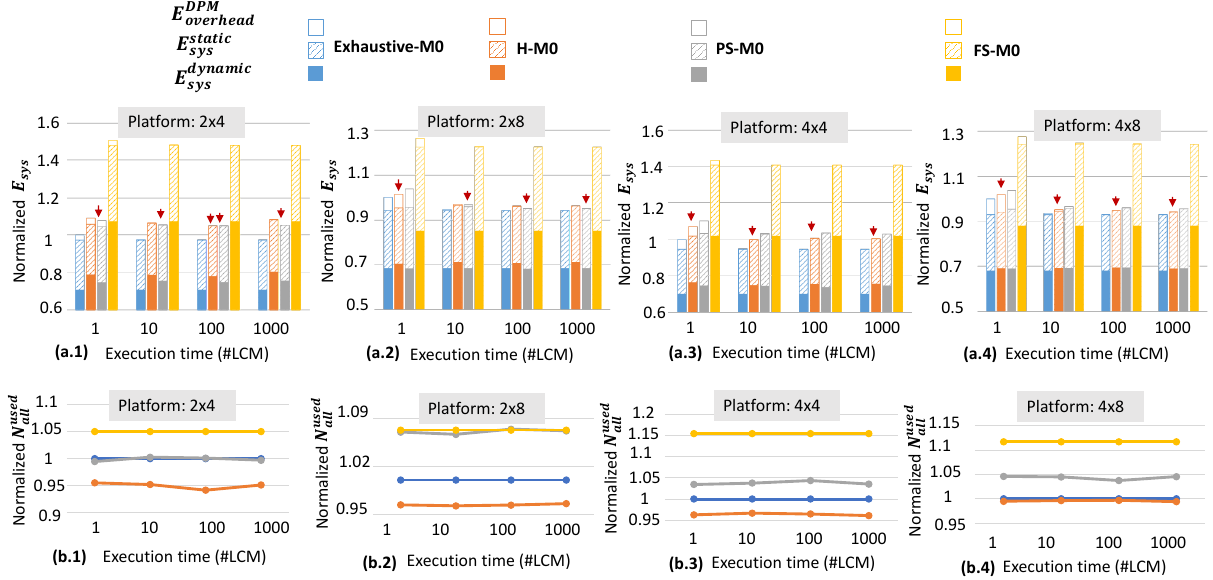
Figure 6. ( a.1 – a.4 ) Normalized E sys (i.e., E dynamic sys + E static sys + E DPM , averaged in an LCM) and overhead ( b.1 – b.4 ) normalized N used (with regard to exhaustive-M0, #LCM = 1) in all common feasible use all cases for different platform sizes. Results are given for different management strategies allowing 0 migration, under constraints of increasing executing time (by using Power static ∝ f 2 model, SER = 0.1). Note : For a better demonstration, the energy of the fully separate strategy is shrunk by a factor of 2, 3, 5 in 2 × 8, 4 × 4 and 4 × 8, respectively. H: holistic strategy, PS: partially separate strategy, FS: fully separate strategy, -M0: allowing 0 migration across